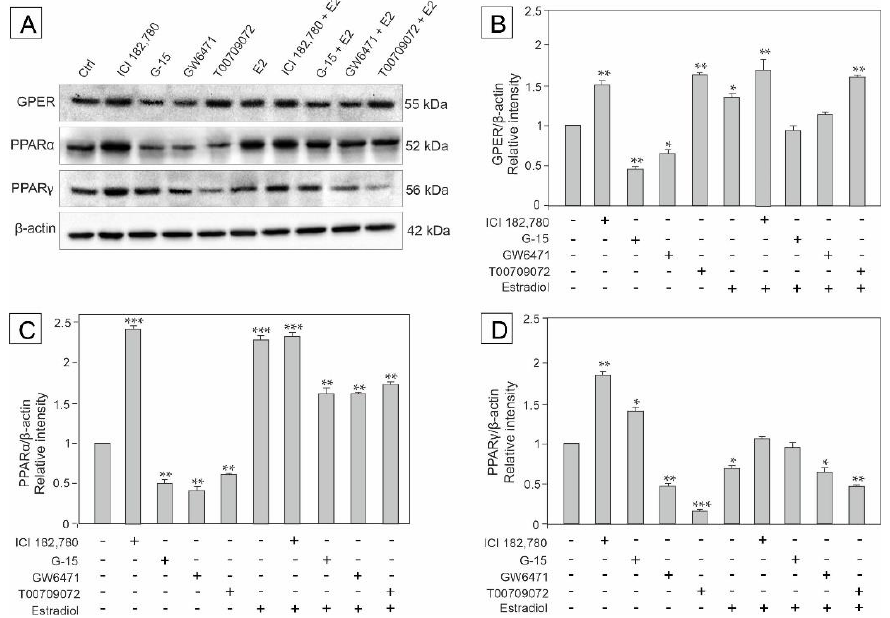
Figure 1. The effect of GPER agonist (ICI 182,780), GPER antagonist (G-15), PPAR α antagonist (GW6471), PPAR γ antagonist (T00709072), and estradiol (E2) on GPER, PPAR α , and PPAR γ protein expression levels in mouse testis explants ( A – D ). Representative blots of Western analysis ( A ) and relative expression of the proteins ( B – D ). Explants were harvested after 24 h. Untreated explants served as a control. Protein levels within control testis explants were given a value of 1. The cropped blots are displayed and the original blots are provided in Supplementary Materials (Figure S1). The relative levels of the proteins were normalized to β -actin which served as the internal protein loading control. The histograms are the quantitative representation of data (mean ± SD) of three independent experiments, each in triplicate ( B – D ). A plus sign (+) indicates the presence of the compound in the culture medium, a minus sign (–) indicates no compound in the culture medium. Asterisks indicate significant differences from control explants. Values are denoted as * p < 0.05, ** p < 0.01 and *** p <